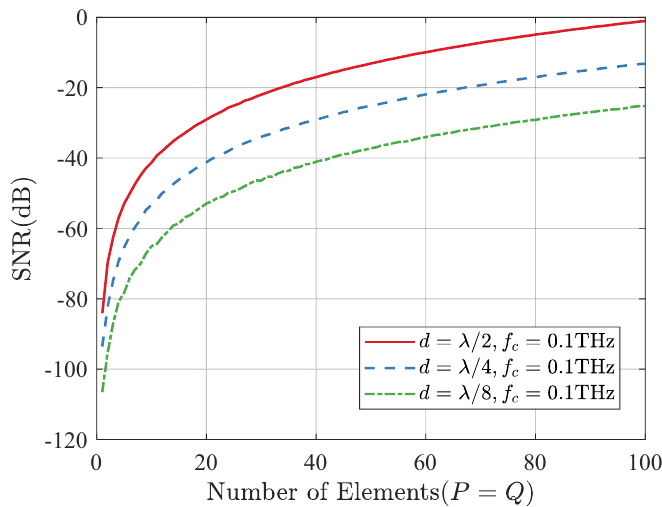
Figure 6. The Influence of different RIS reflection unit sizes on the auxiliary link